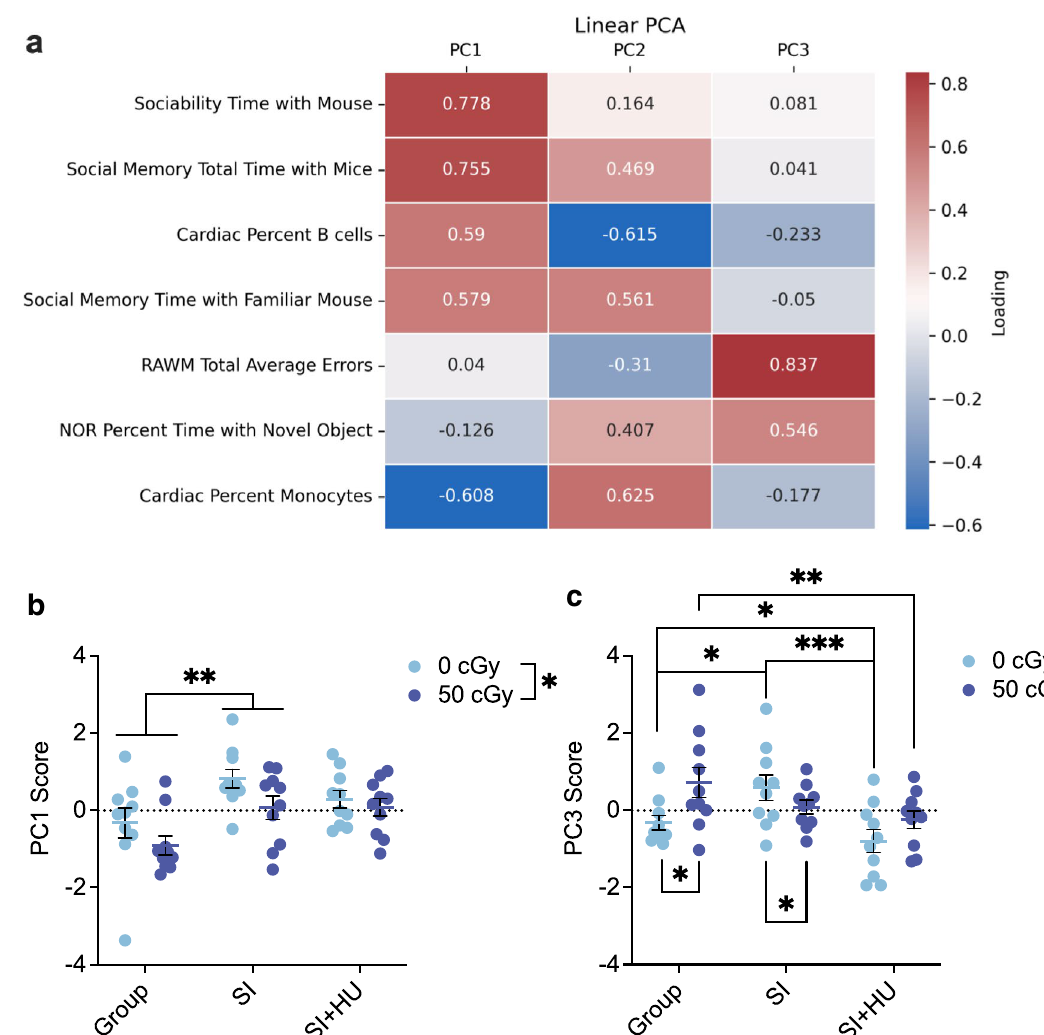
Figure 6. Linear PC Scores are modeled by Housing and GCRsim. ( a ) Loadings for features in the Linear PCA. Scores greater than |0.45| were used for interpretation of the PC. ( b ) PC1–Social exploration measures and B cells percentage from cardiac blood loaded strongly positively, while monocyte percentage from cardiac blood loaded strongly negatively on PC1. Two-way ANCOVA analysis had the best model fit for PC1. There was a significant main effect of housing (F(2,33) = (5.816, p = 0.007, η 2 = 0.261) and GCRsim (F(1,33) = 6.694, p = 0.014, η 2 = 0.169) on PC1. SI stress increased PC1 score compared to group housing (mean diff 1.155, 95%CΙ (0.294 to 2.015), p = 0.006). Sham irradiated animals scored higher on PC1 than 50 cGy exposed animals (mean diff 0.967, 95%CI (0.207 to 1.728), p = 0.014). ( c ) PC3- RAWM average errors and NOR percent time with the novel object loaded strongly positively. Two-way ANCOVA analysis including percent monocytes in early blood as a covariate had the best model fit for PC3. There was a significant interaction between GCRsim and housing condition (F(2,33) = 4.827, p = 0.014, η 2 = 0.226). Compared to shams, the 50 cGy exposed mice scored higher in group housing (mean diff 0.906 (95%CI (0.015 to 1.797), p = 0.047) and lower in SI housing (mean diff − 0.948, 95%CI (− 1.890 to − 0.007), p = 0.048). Within all sham exposed animals, SI animals scored higher than both SI + HU (mean diff 2.496, 95%C (1.272 to 3.720), p < 0.001) and group housed animals (mean diff 1.276, 95%C (0.212 to 2.341), p = 0.014). Sham group housed males scored higher than SI + HU animals (mean diff 1.220, 95%C (0.019 to 2.420), p = 0.045). Within all 50 cGy animals, group housed scored higher than SI + HU animals (mean diff 2.180, 95%CΙ (0.482 to 3.878), p = 0.008). Males n = 9 0 cGy group, 0 cGy SI; n = 8 50 cGy group; n = 7 50 cGy SI; n = 5 0 cGy SI + HU; n = 2 50 cGy SI + HU. * p < 0.05 ** p < 0.01, *** p < percentage from early blood and PC1 score was not significant (r(38) = − 0.196, p = 0.226). Overall, GCRsim reduced while SI stress increased PC1 score. Monocyte percentage in early blood did not predict PC1 score on its own, but did it improve models as a covariate. The overall fit of the two-way ANOVA was F(5,54) = 4.252, p = 0.002, η 2 = 0.282, adj R 2 = 0.216). Includ- ing percent monocytes in early blood as a covariate improved the fit of the model (F(6,33) = 6.925, p < 0.001, η 2 = 0.557, adj R 2 = 0.477) (Fig. 6c). Overall, the data show GCRsim exposure elevates PC3 scores among group